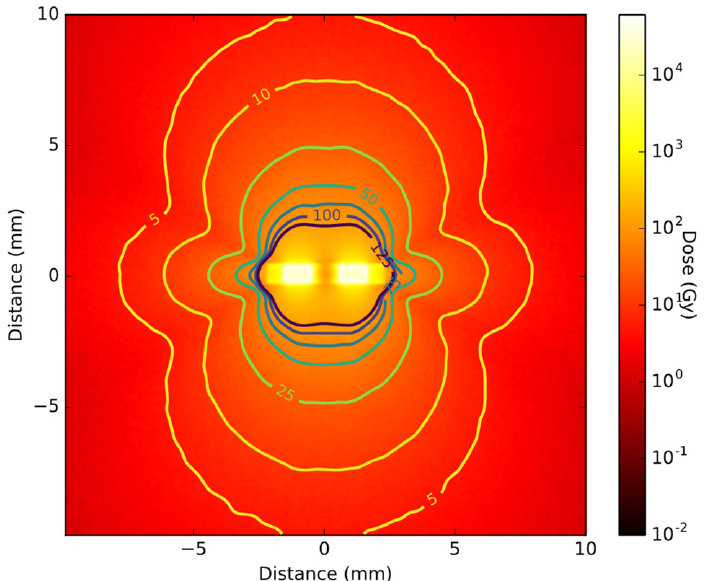
Figure 9. Cross-section view of the 2D dose distribution of the commercial seed, with iso-dose lines ranging from 5% dose to 125% dose.